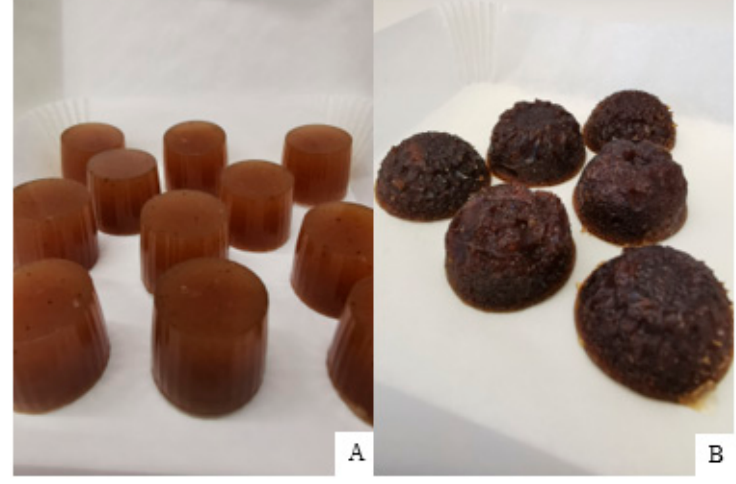
Figure 5. Gel tablets’ appearance ( A ) gelatin gel tablets; ( B ) pectin gel tablets.